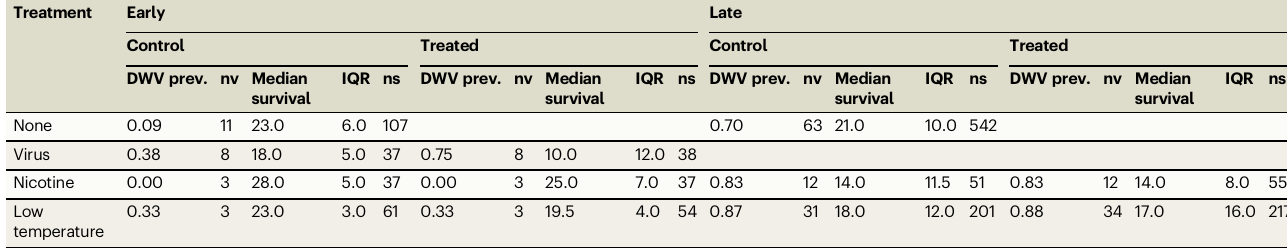
Table 1 | DWV infection and survival of the honey bees used in the lab experiments Treatment Early Late Control Treated Control